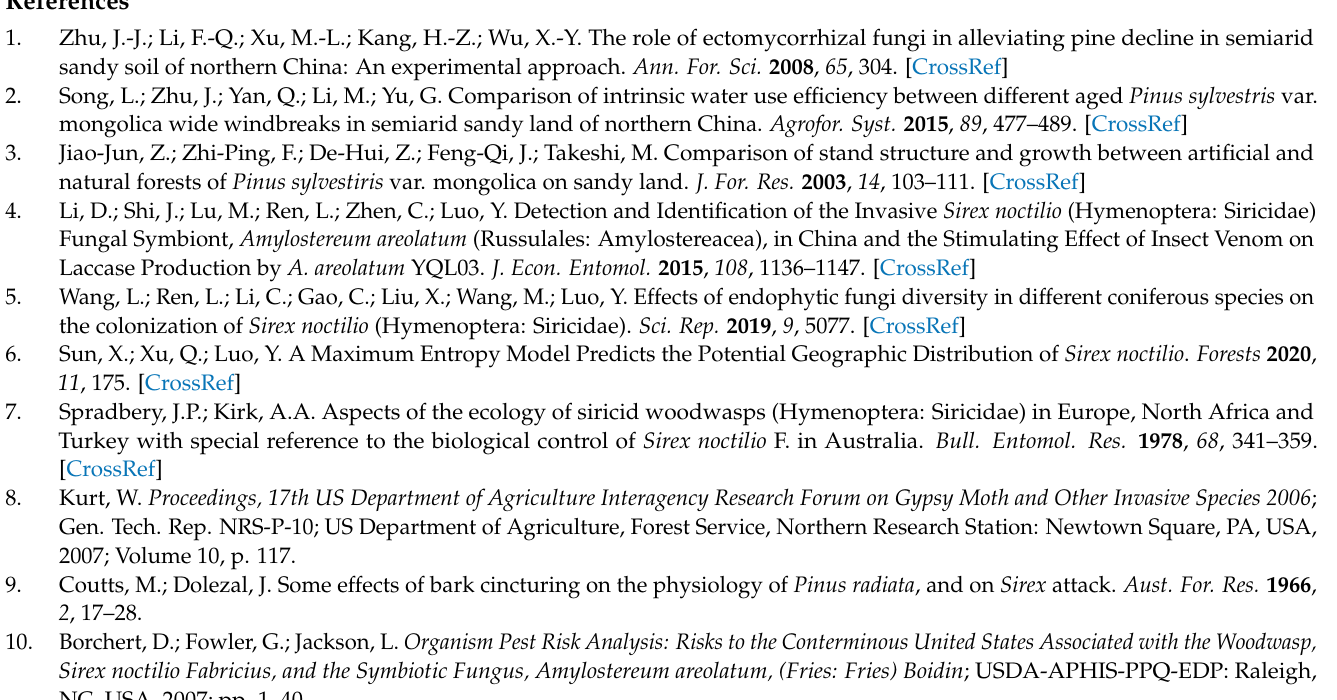
Figure S2: Unigene number distribution of TF families. Table S1: The quality assessment of the 27 samples. Table S2: Summary of RNA-sequencing data from 27 RNA libraries and comparison with full-length unigenes. Table S3: Summary of 706 DEGs specifically induced by S. noctilio venom. Table S4: 21 DEGs significantly enriched in “plant–pathogen interaction” KEGG pathway under S. noctilio venom-specific induction. Table S5: 14 DEGs significantly enriched in “photosynthesis- antenna proteins” KEGG pathway under wounding-specific induction. Table S6: 4 DEGs significantly enriched in “nitrogen metabolism” KEGG pathway under co-induction of venom and